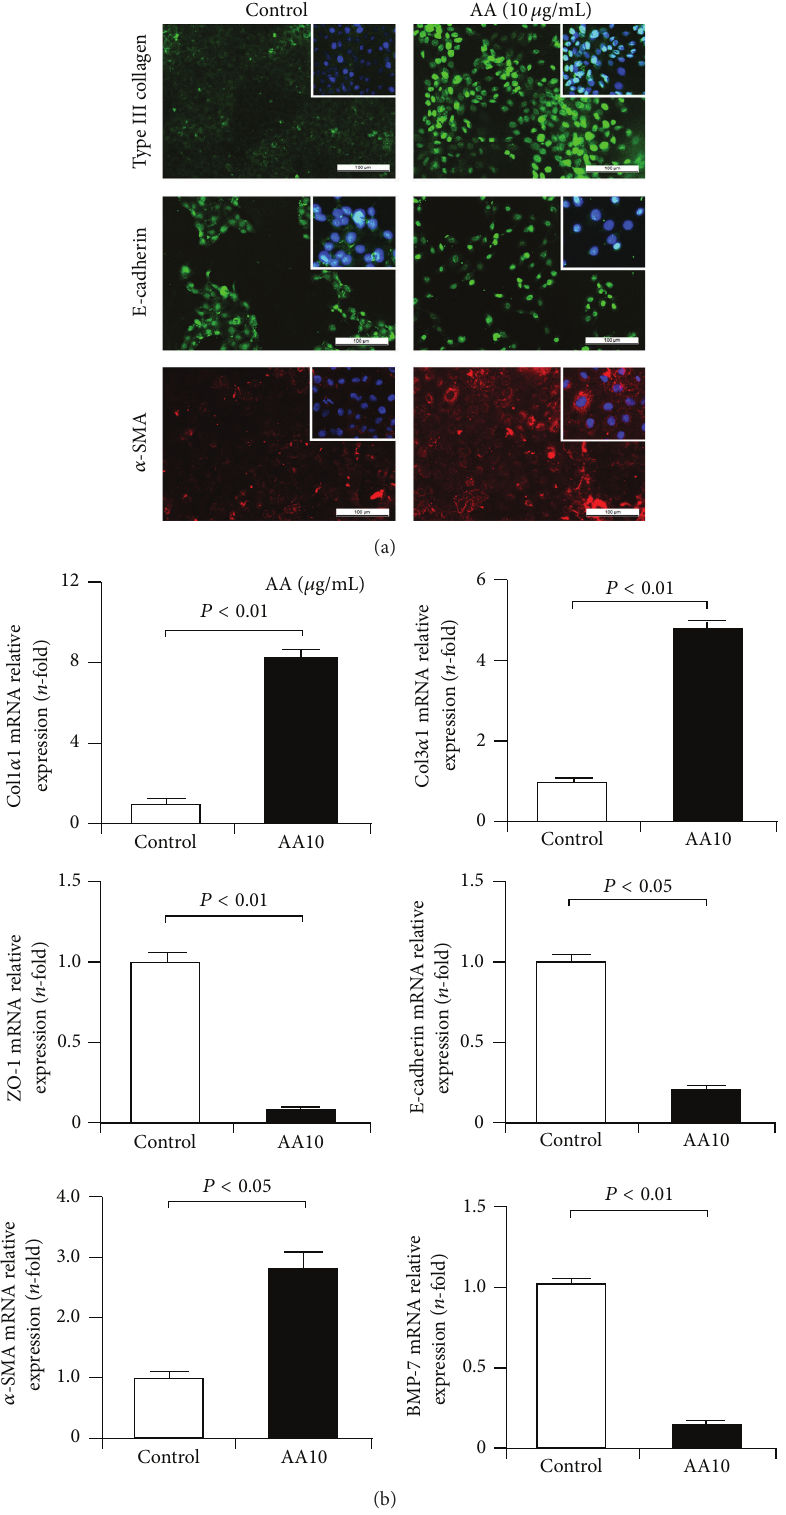
Figure 4: EMT and matrix deposition in AA-treated TECs. (a) Immunofluorescence staining revealed enhanced expression of type III collagen and 𝛼 -SMA and decreased expression of E-cadherin in AA-treated NRK-52E cells. Bar: 100 𝜇 m. (b) qRT-PCR assay showed that the mRNA expression of Col1 𝛼 1, Col3 𝛼 1, and 𝛼 -SMA was upregulated in NRK-52E cells after AA treatment, and the expression of ZO-1, E-cadherin, and BMP-7 was